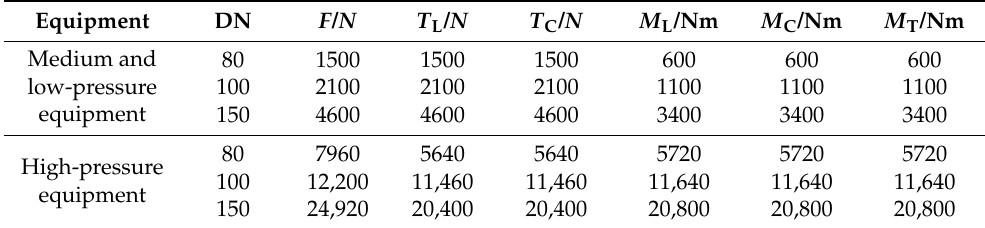
Table 3. The allowable load of the equipment